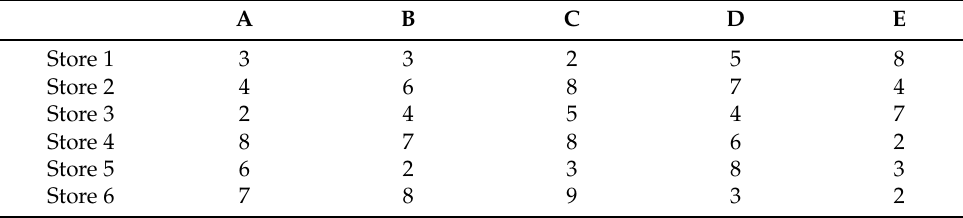
Table 2. Available book units offered in the six Internet